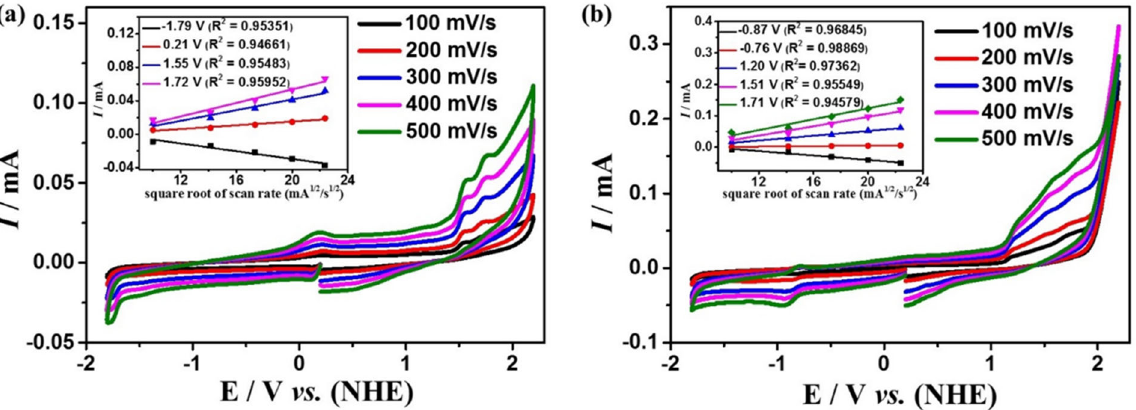
Figure 2. Cyclic voltammogram of 0.5 mM complexes 1 ( a ) and 2 ( b ) in the DMF solution, the sweep speed range is 100–500 mV s − 1 . The insets of ( a , b ) are the linear relationship between the irreversible peak current and the square root of the scan rate mA 1/2 /s 1/2 at different potentials for 1 and 2 , respectively.